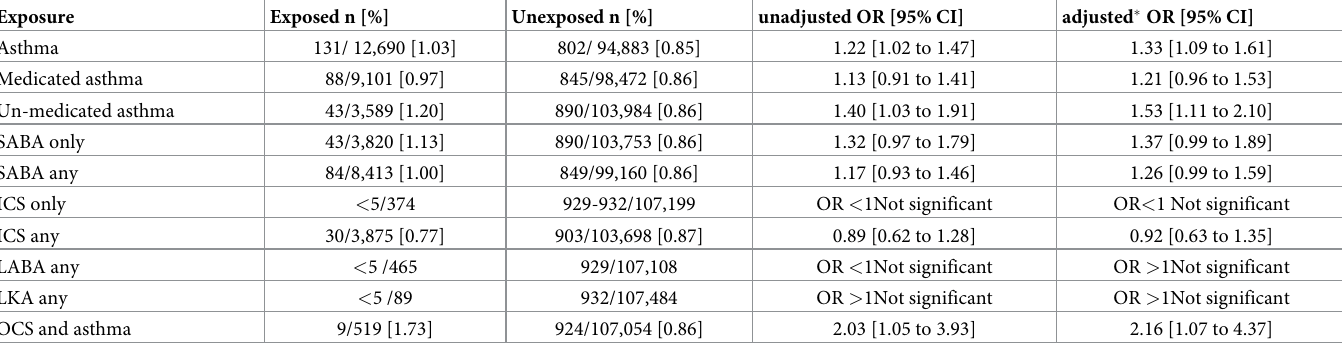
Table 3. Premature birth < 32 weeks (n =